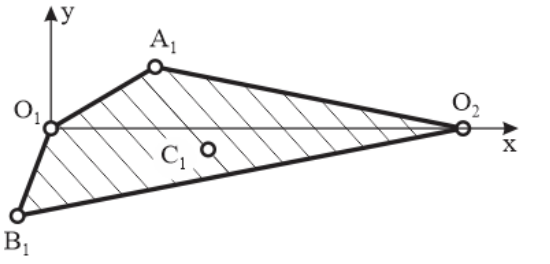
Figure 3. Schematic representation of the robotic arm with the connection points and the association of this structure with some hydraulic cylinders.